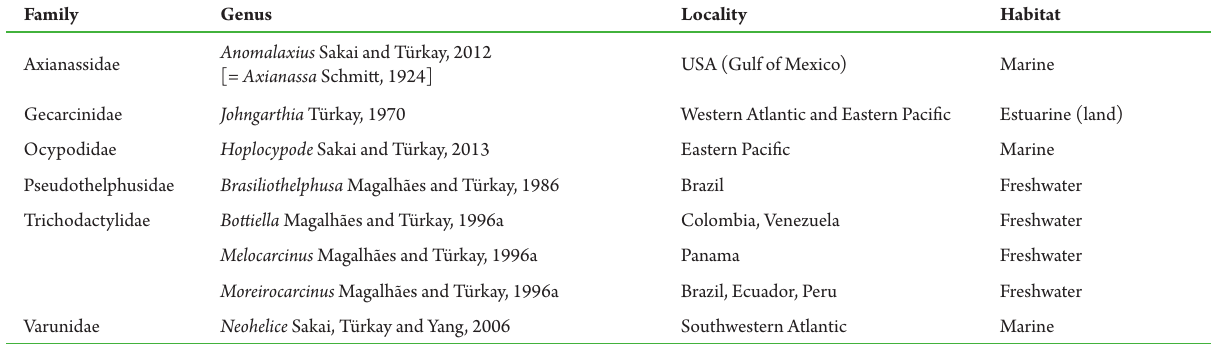
Table 1. Genera of New World decapod crustaceans described by Michael